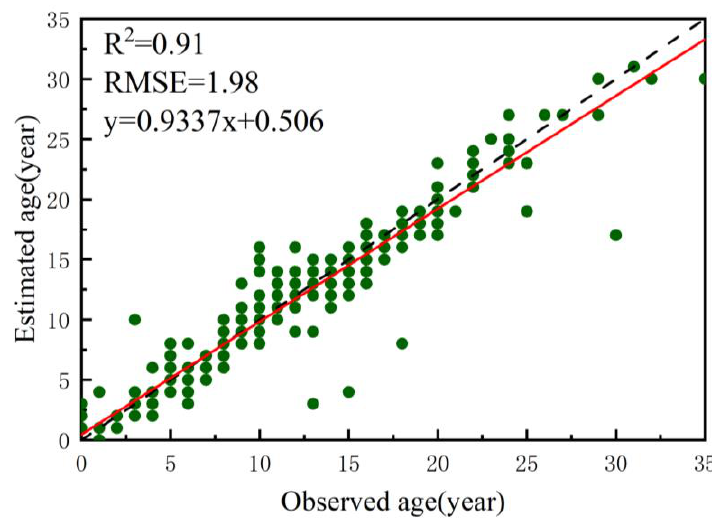
Figure 11. Accuracy verification of forest age.